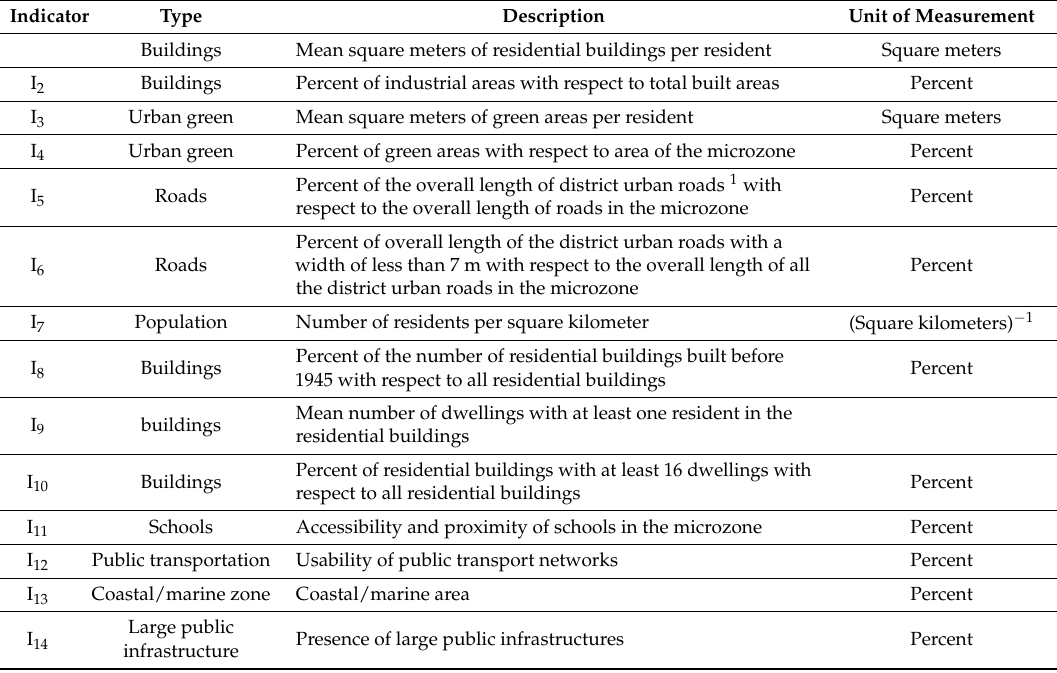
Table 1. Indicators used to classify the microzones of the area of